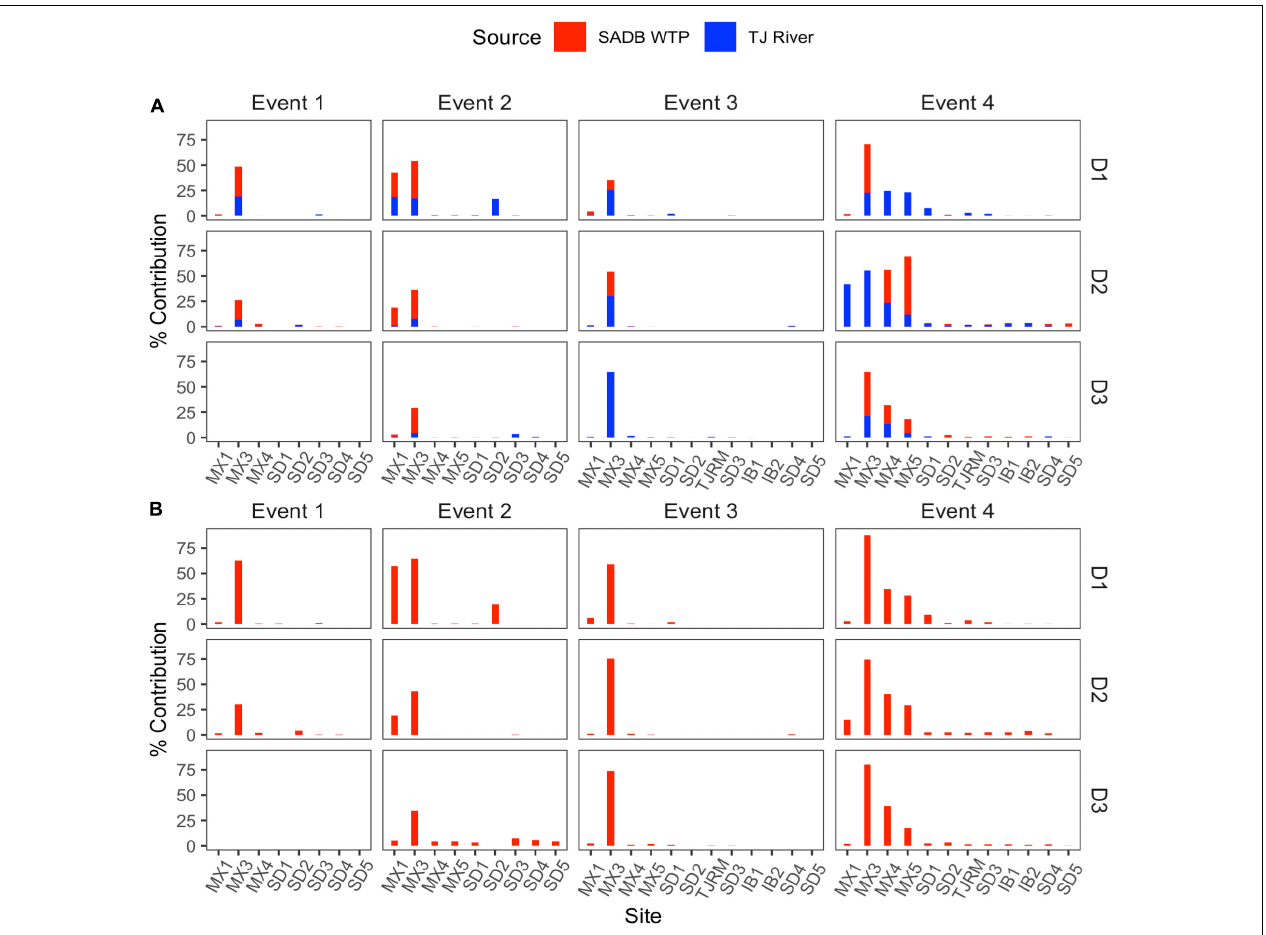
FIGURE 4 | Contributions from potential sources (SADB WTP and Tijuana River) in each sink site using SourceTracker. Sites are arranged from a north to south along the x -axis. (A) SADB WTP included as the only source. (B) SADB WTP and Tijuana River included as potential